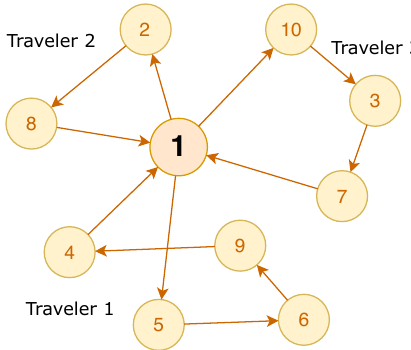
Figure 5. The traversal route of the chromosome in Figure